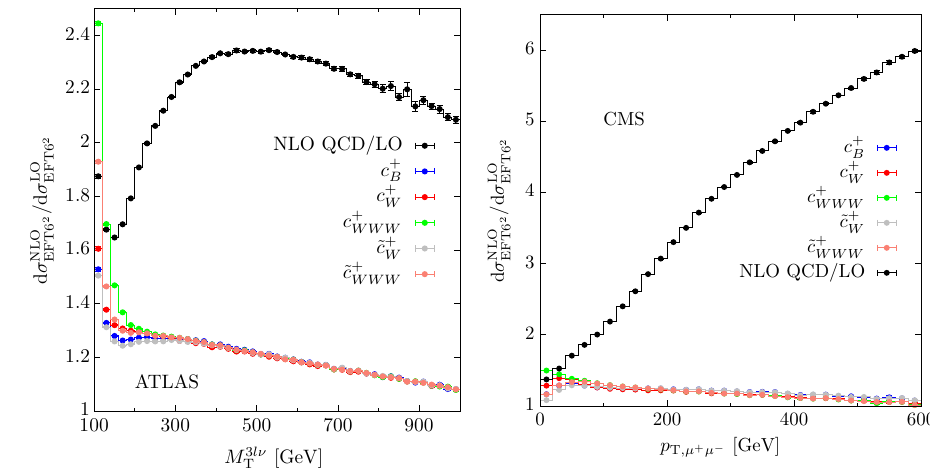
Table 4 Fiducial cross section for the process pp → e + e − μ + μ − at √ s = 13TeV in the setup of Eqs. (4.11). The numbers in parentheses correspond to the statistical error on the last digit. The uncertainties are estimated from the scale dependence, as explained in the text LO [fb] NLO QCD [fb] NLO EW [fb] gg [fb] 11 . 0768 ( 5 ) + 6 . 3% − 14 . 993 ( 2 ) + 3 . 1% − 10 . 283 ( 2 ) + 6 . 4% − 1 . 8584 ( 4 ) + 25% − 2 . 4% 7 . 6% 18% 7 . 5%